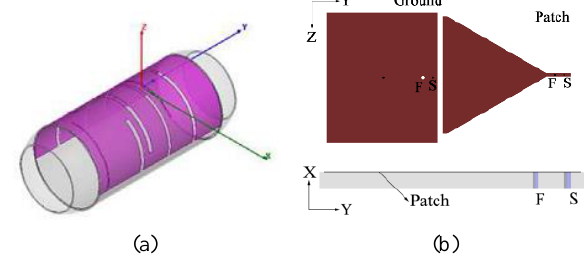
Figure 1. (a) Geometry of the proposed ingestible antenna. (b) Geometry of the proposed on-body antenna.